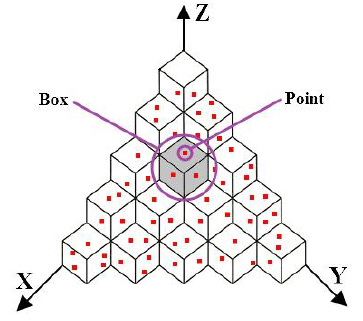
Figure 5. Box-counting dimension calculating sketch